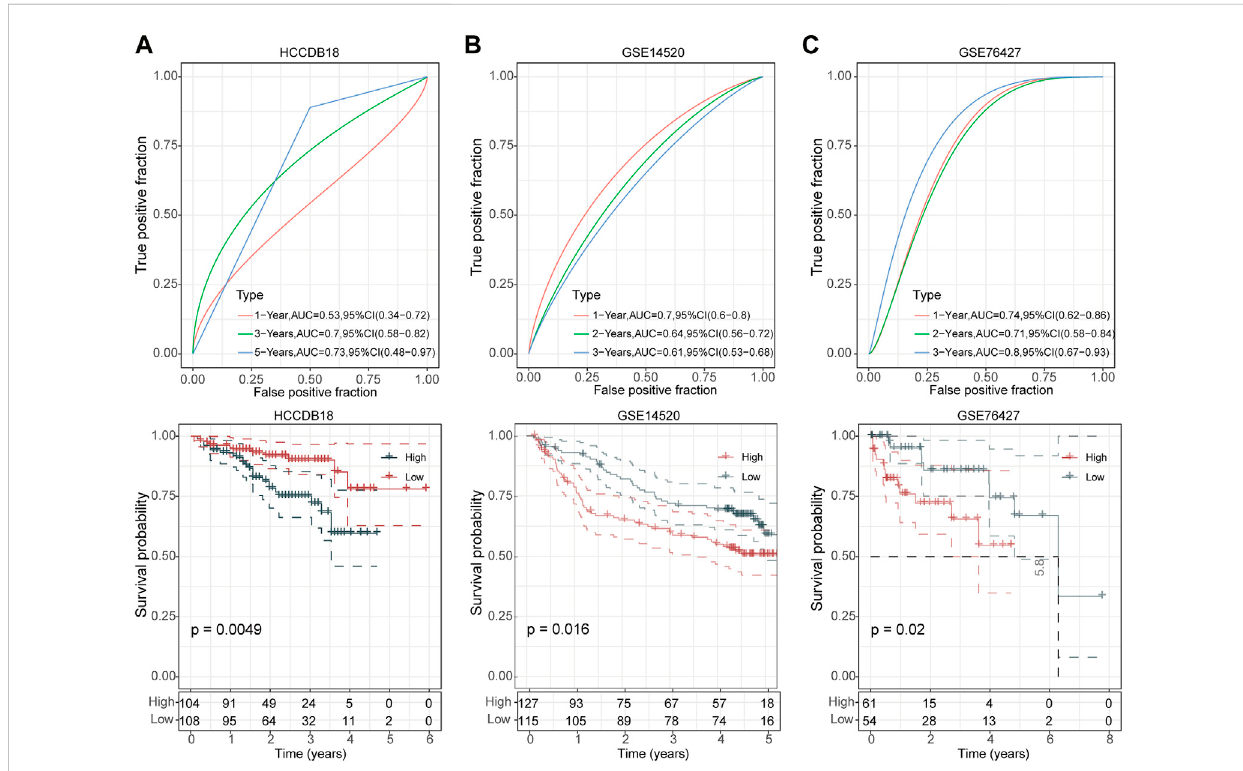
FIGURE 4 Validation ofUPS-basedprognostic modelin threeindependentdatasets. ROC analyses oftherisk model for 1-year, 3-year, and5-year OS (up)and Kaplan-Meier curves of high- and low-risk patients (down) in the HCCDB18 cohort (A) , GSE14520 cohort (B) , and GSE76427 cohort (C) ,